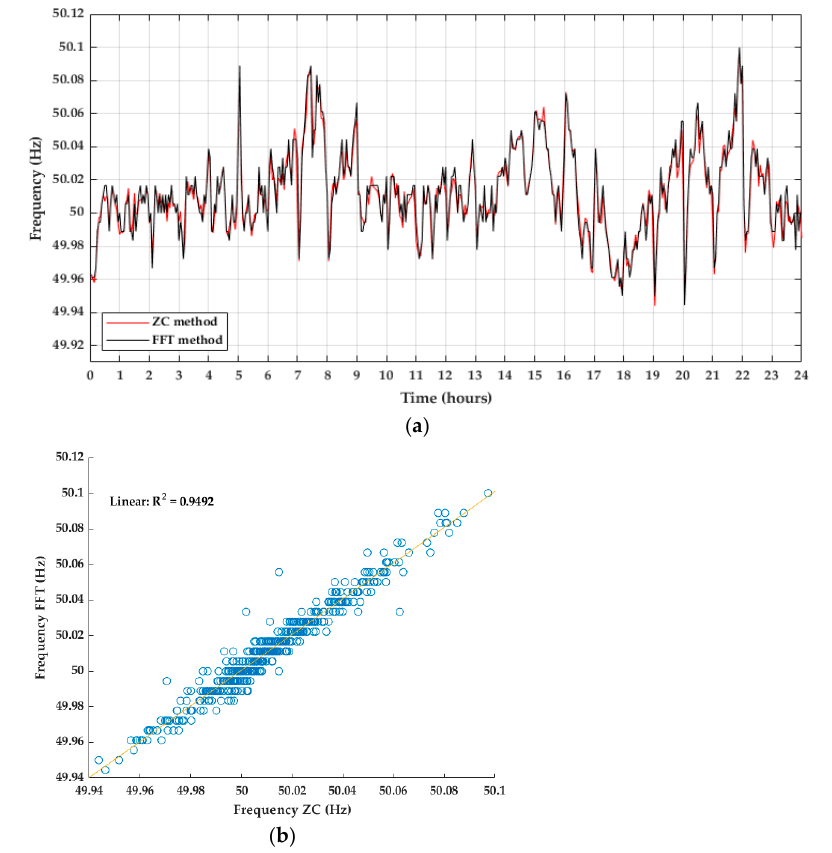
Figure 8. Comparison between ZC and FFT methods. ( a ) Daily frequency of 3 May 2021; ( b ) Linear regression.